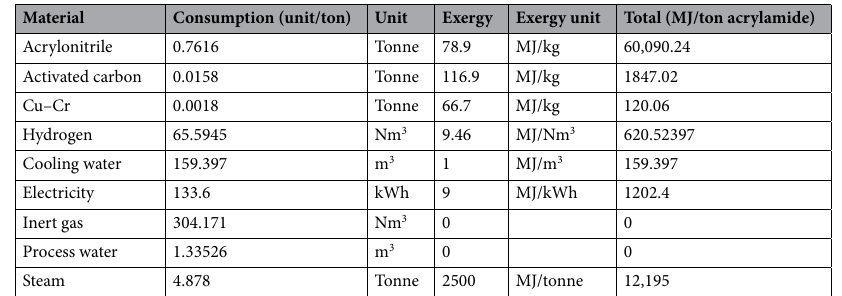
Table 3. Material and exergy required for manufacturing of acrylonitrile by catalytic hydration 36,37 .